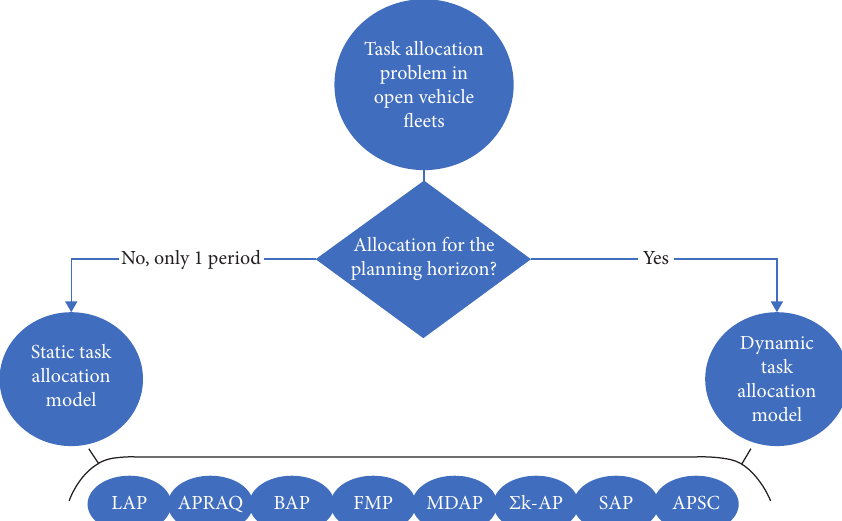
Figure 1: Static and dynamic task assignment problems in open vehicle